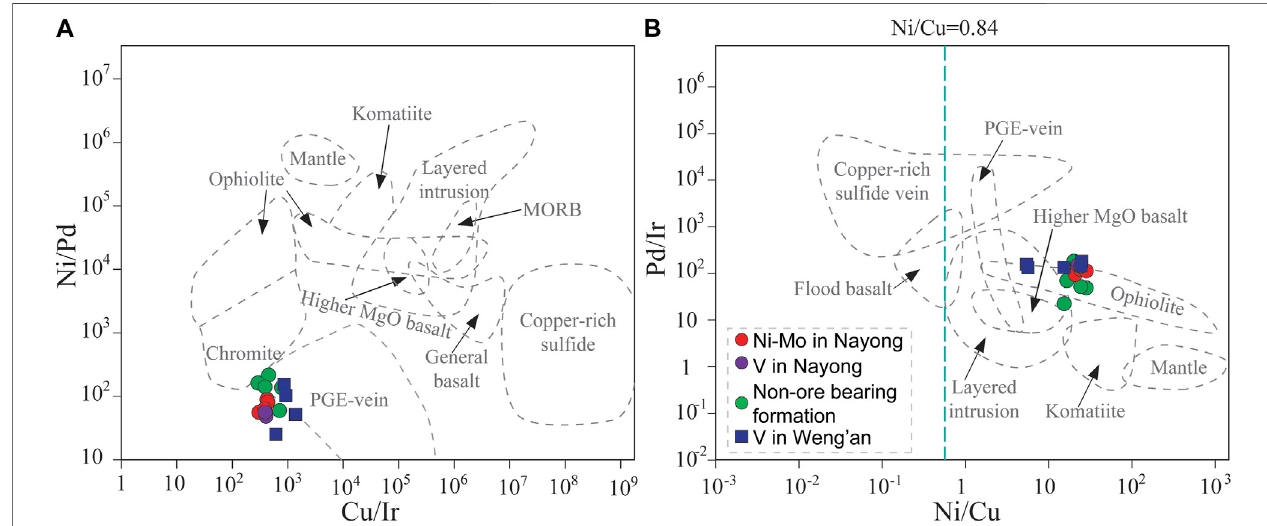
FIGURE 8 | (Cu/Ir) – (Ni/Pd) and (Ni/Cu) – (Pd/Ir) diagrams for black shale and the polymetallic layer at the base of the Cambrian pro fi le in Nayong – Weng ’ an (after Pa ˇ sava et al., 2003).